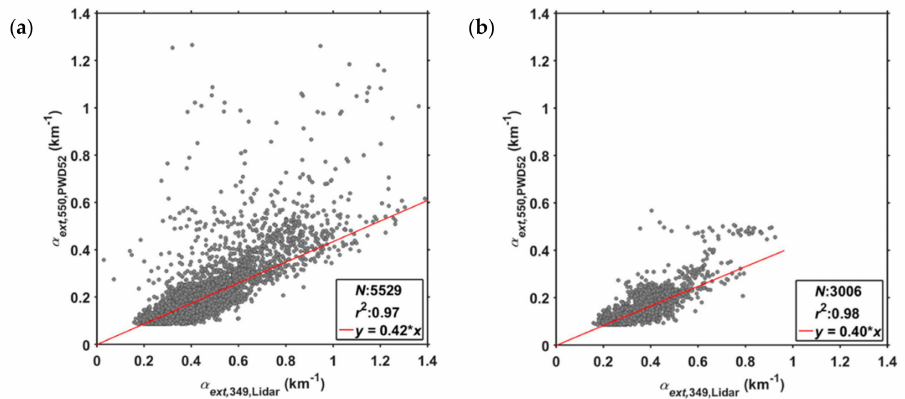
Figure 6. Correlation plot between the aerosol extinction coe ffi cient, α ext , at 349 nm (near-horizontal lidar) and α ext at 550 nm (visibility-meter) obtained by ( a ) disregarding rain events (i.e., excluding all the 5 min data with the rain flag), and ( b ) disregarding rainy days (i.e., excluding all the data from November 3, 4, 8, 11, 13–15, 22–24 and 30). The values of r 2 are based on the least absolute residuals (LAR) regression analysis, and N is the total number of data points (average over 5